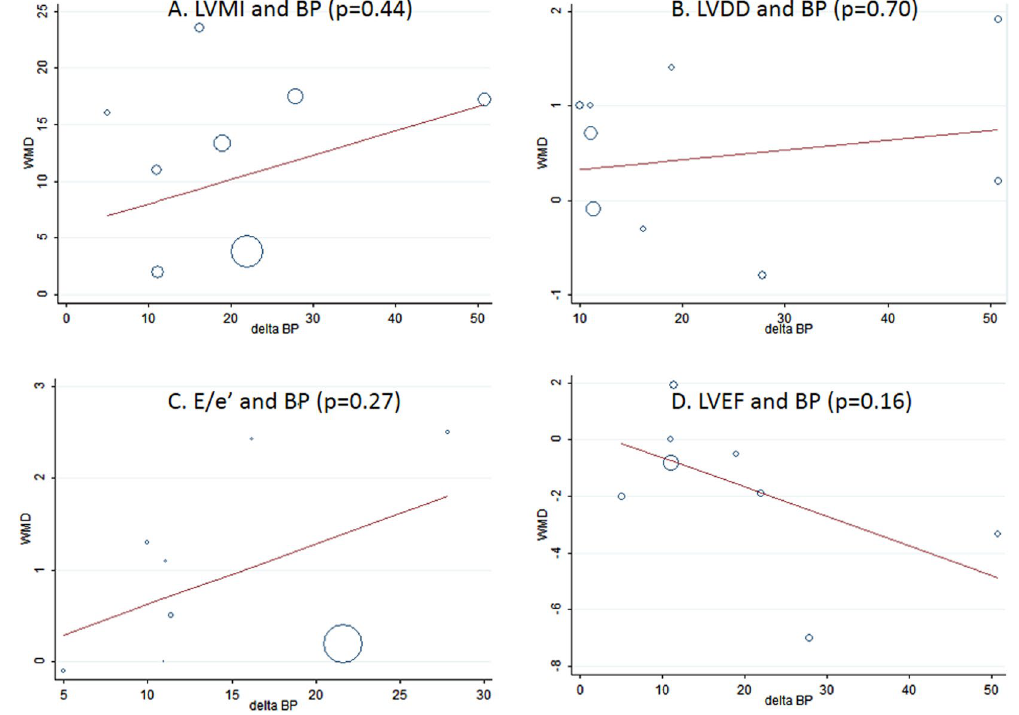
Figure 7. Meta-regression analysis showing the relationship between changes in ( A ) LVMI, ( B ) LVDD, ( C ) E/e’, ( D ) LVEF and systolic BP